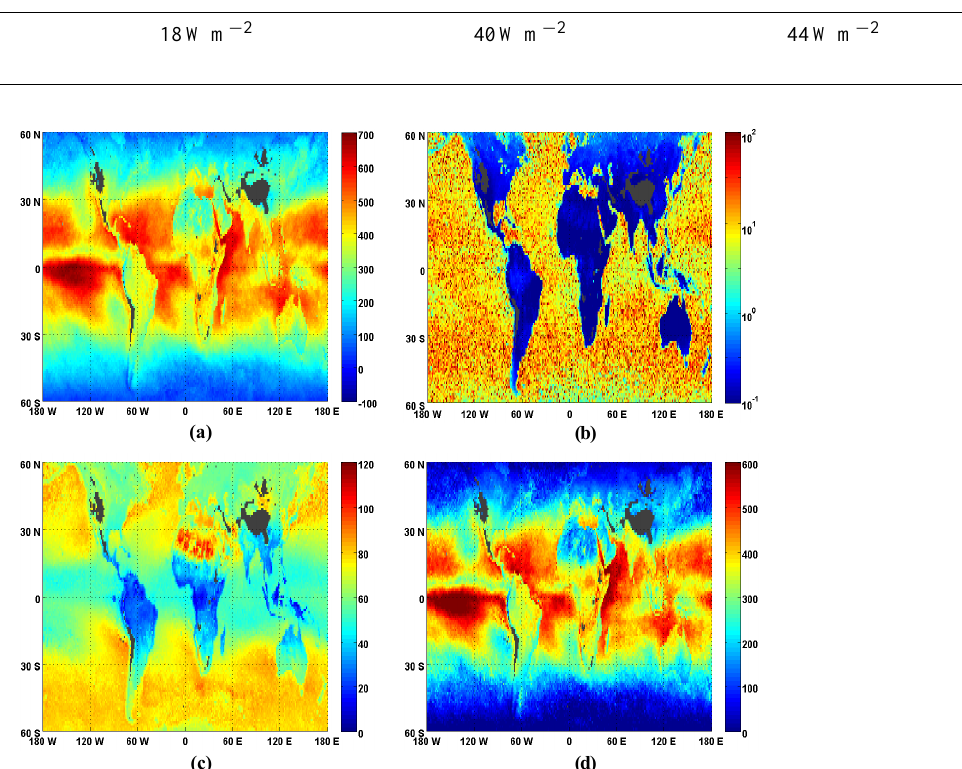
Figure 5. Global fields for annual average (year 2003) 13:30LT: (a) net radiation, R N (Wm − 2 ) ; (b) surface heat capacity, c (MJm − 2 K − 1 ) ; (c) surface heat accumulation rate, G (Wm − 2 ) ; (d) net available energy, (cid:56) (Wm − 2 )